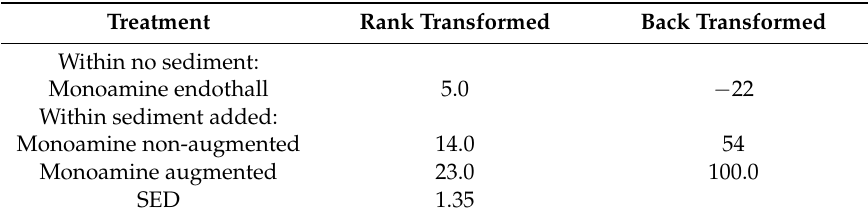
Table 8. Effect of treatment on the percent decline of isomer-2, from day-0 to day-21. SED = Standard error of the difference. Treatment Rank Transformed Back Transformed Within no sediment: Monoamine endothall 5.0 − 22 Within sediment added: Monoamine non-augmented 14.0 54 Monoamine augmented 23.0 100.0 SED 1.35